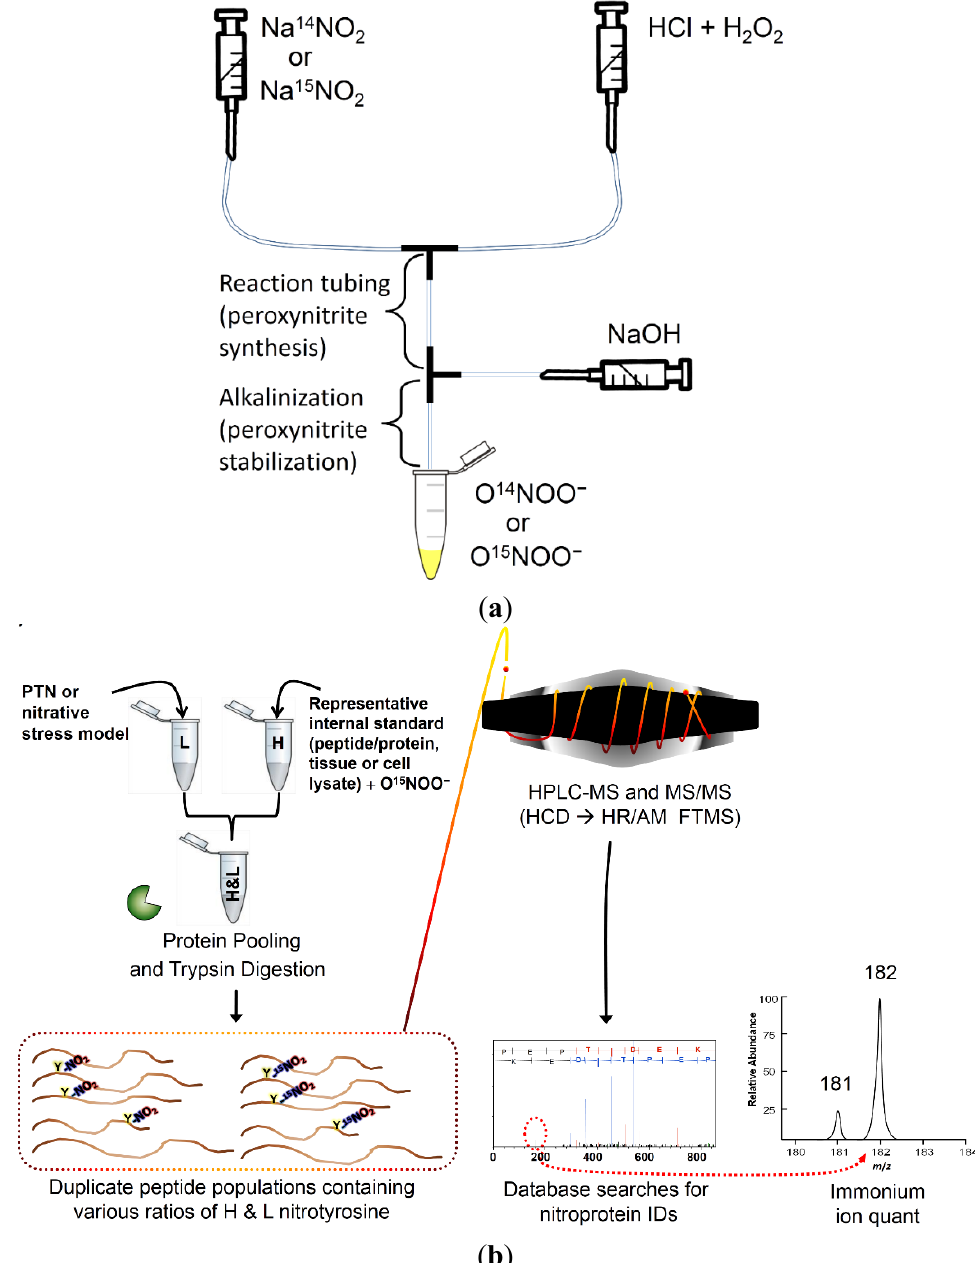
Figure 1. ( a ) Experimental setup used for standard or 15 N-labeled peroxynitrite synthesis; and ( b ) the proposed workflow for nitration identification and relative quantitation using the stable isotope-labeled nitrated spike-in standard approach. L, light-labeled peroxynitrite; H, heavy-labeled peroxynitrite; PTN, protein tyrosine nitration; HCD, higher-energy collision-induced dissociation; HR, high resolution; AM, accurate mass; FTMS, Fourier transform